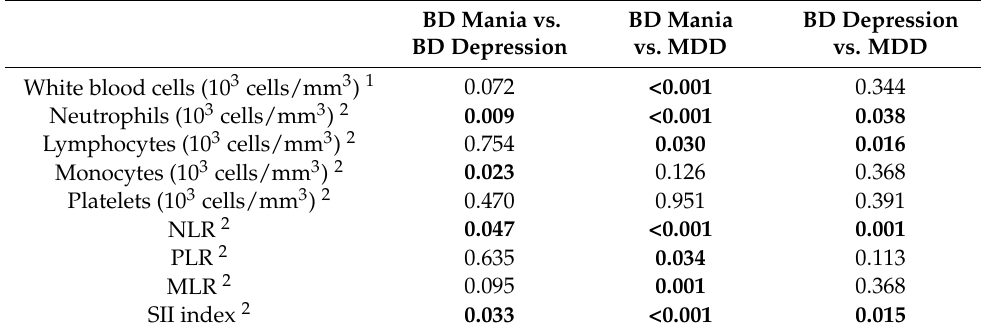
Table 3. Comparison of laboratory variables and ratios between